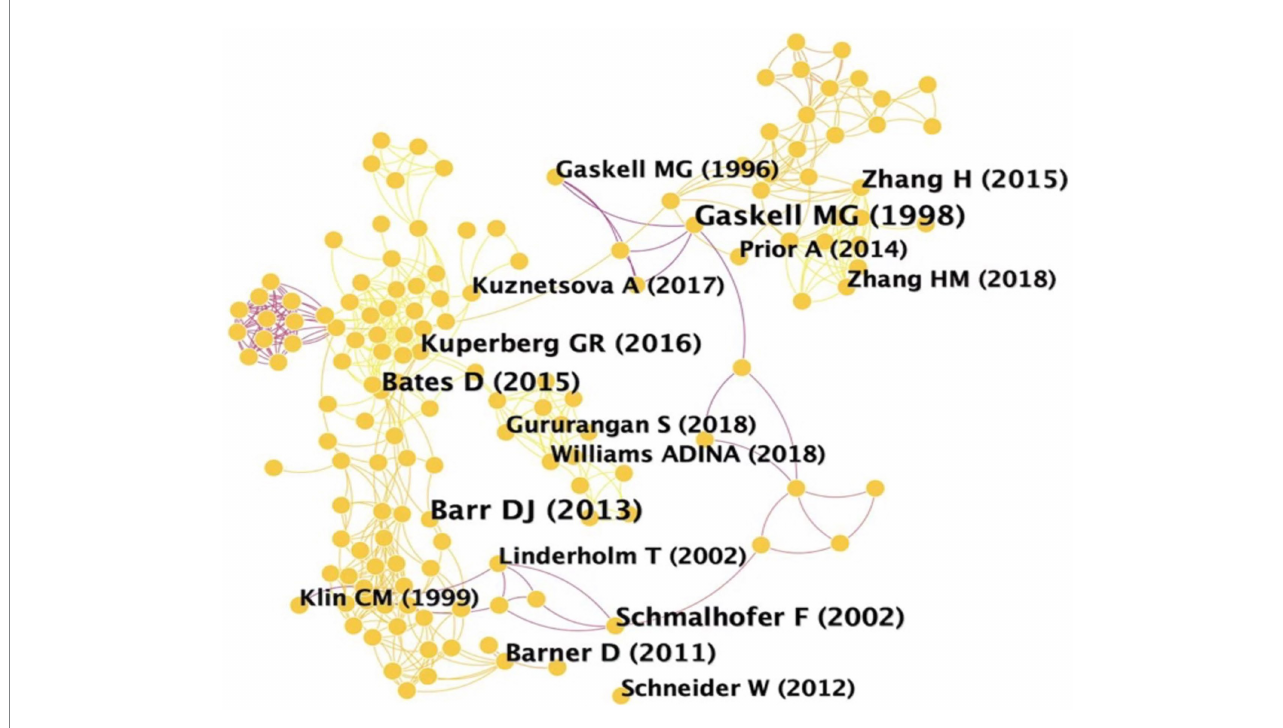
FIGURE 3 Network map of the most cited articles of lexical